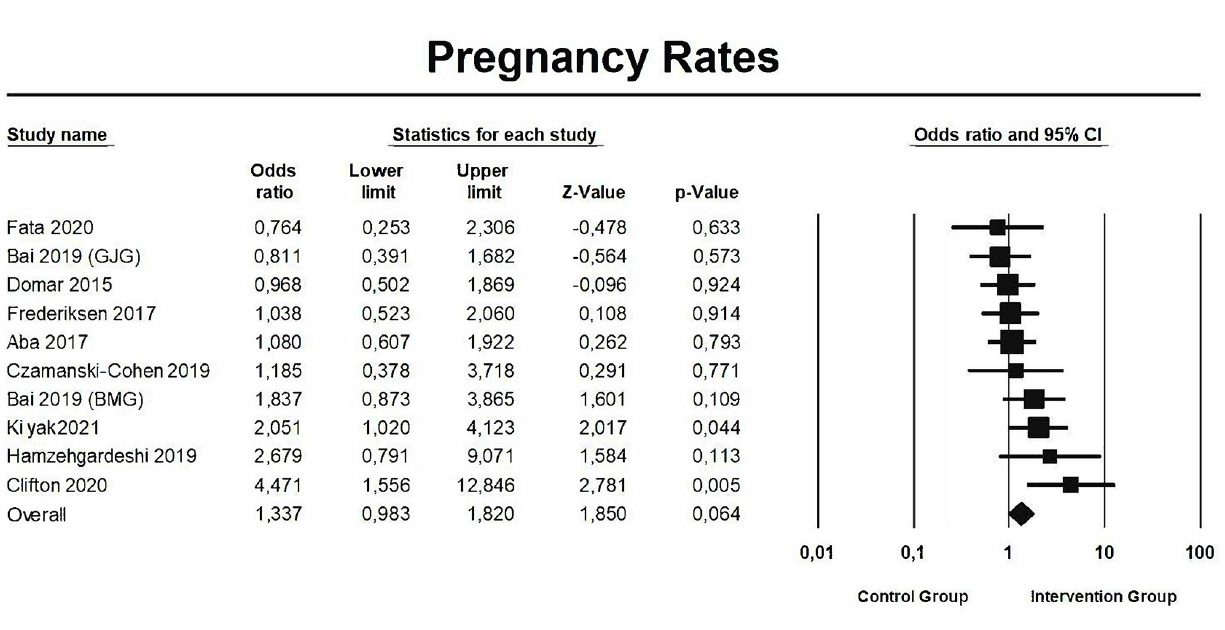
PLOS ONE | https://doi.org/10.1371/journal.pone.0282065 February 28,